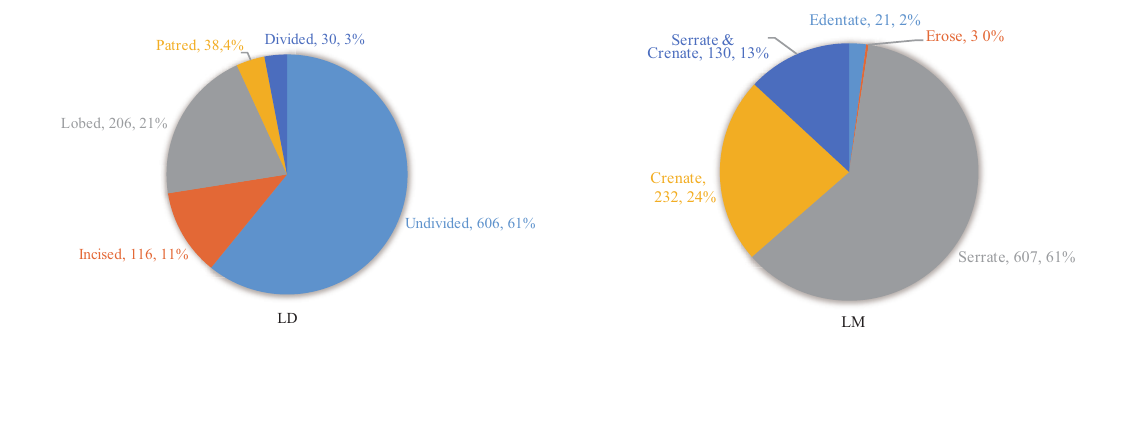
Frequency distribution of leaf division (LD). Frequency distribution of leaf margins